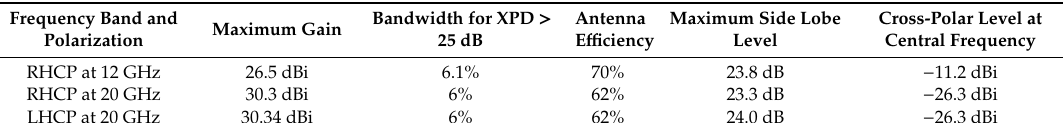
Figure 8. Main cuts of the simulated radiation patterns at 12 GHz for right-hand circular polarization (RHCP) and 20 GHz for both RHCP and left-hand circular polarization (LHCP). MoM-SD and CST results are shown. ( a ) Elevation cuts. ( b ) Azimuth cuts. Table 1. Overall numerical performance of the designed circular polarization reflectarray that generates RHCP at 12 GHz, and RHCP and LHCP at 20 GHz.